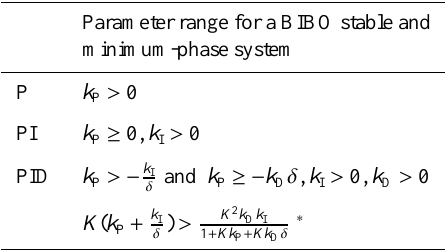
Table B1. Combined parameter range guaranteeing system stability and a minimum-phase system for a drift-a ffl icted sensor with linear